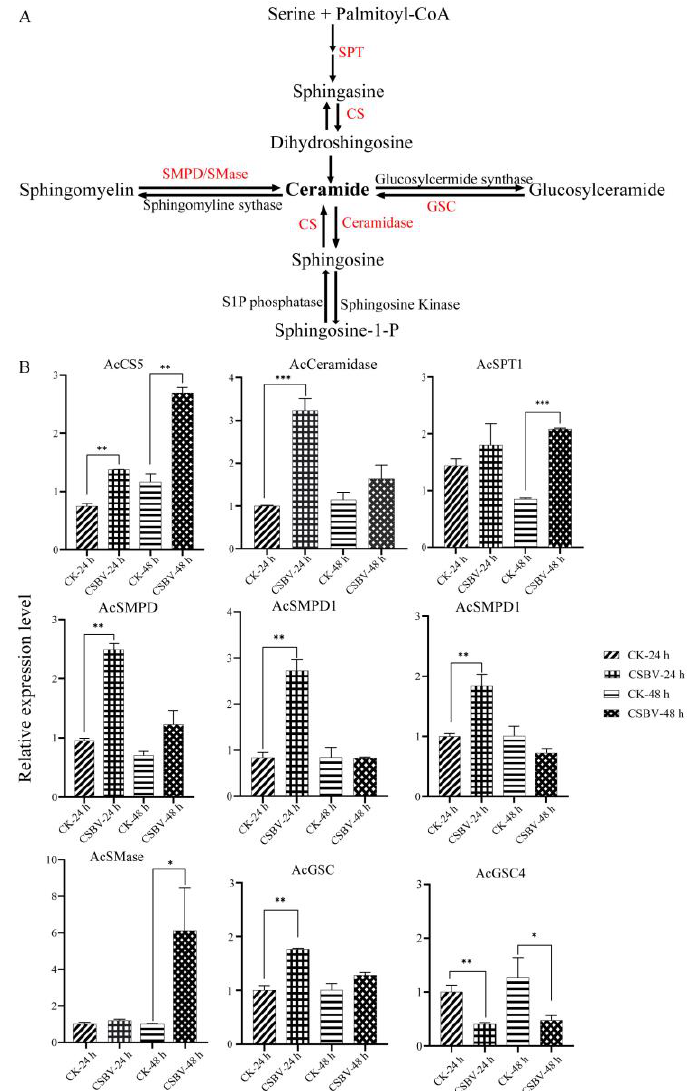
Figure 7. The pathway of sphingolipid metabolism ( A ) and the expression levels of 9 sphingolipid enzymes upon CSBV infection by quantitative real-time PCR ( B ). The enzymes analyzed in this study are in red and full names are listed in Table 1. Data are shown as means ± SE. Asterisks (*) indicates statistically significant p -value of <0.05, ** p -value of <0.01, *** p -value of <0.001.